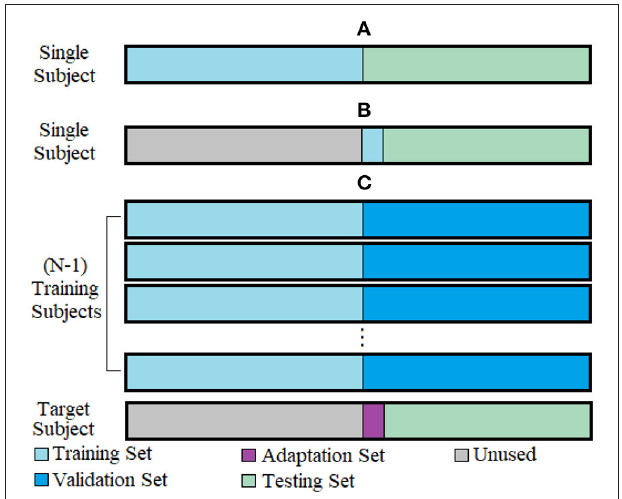
FIGURE 1 | Evaluation frameworks shown for 1-fold of cross-validation. (A) Within-subject framework, (B) Single-repetition framework, (C) Cross-subject